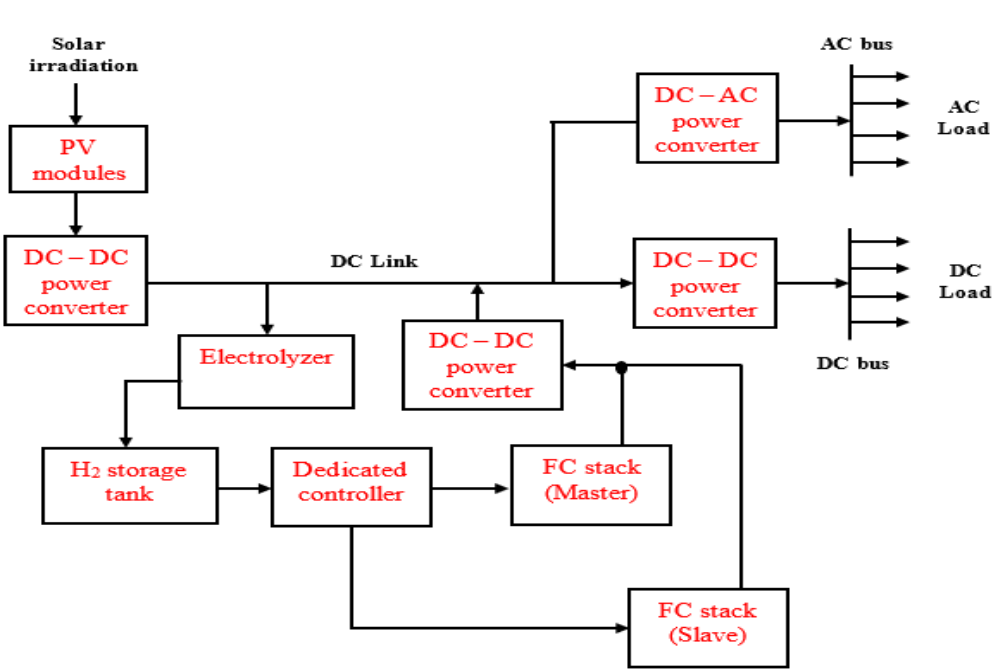
Figure 9. Microgrid system based on solar PV and regenerative FC.